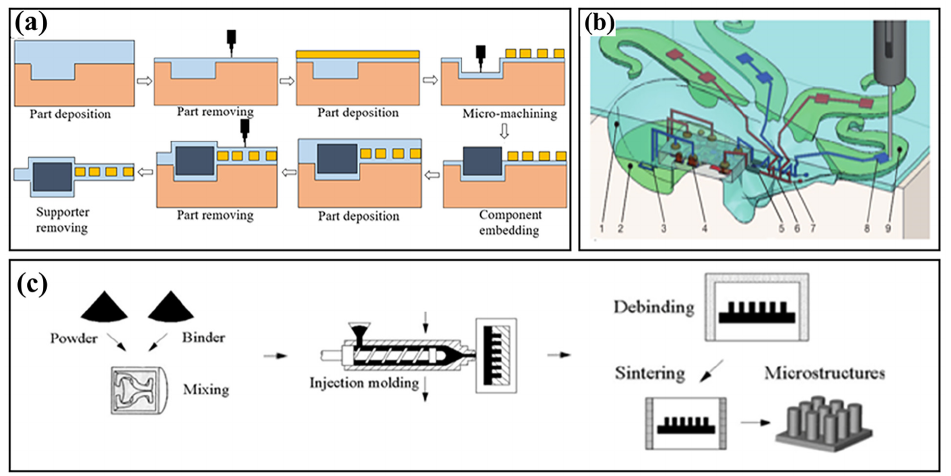
Figure 14. ( a ) Schematic diagram of SDM processes [115]. ( b ) Fully soft robot manufactured by 3D printing [122]. ( c ) Processing steps of micro-powder injection molding